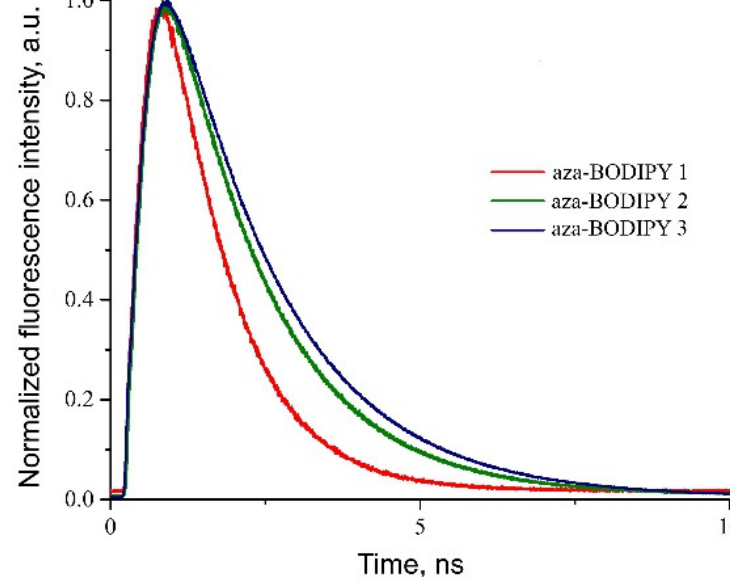
Figure 3. Fluorescence decay curves of aza-BODIPYs 1–3 in toluene.